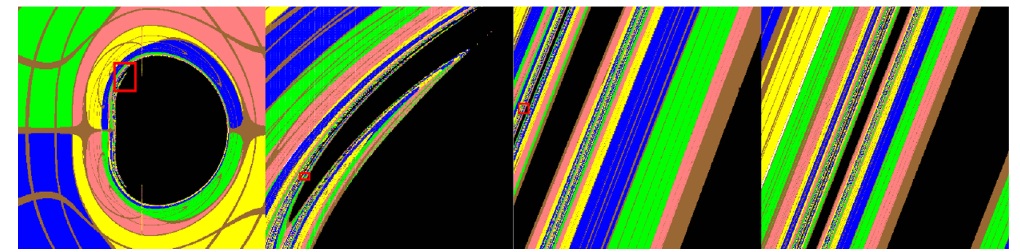
Figure 7 . The enlargement of the left panel in figure 5. It shows that there exist the eyebrow shape shadow and the self-similar fractal structures in black hole